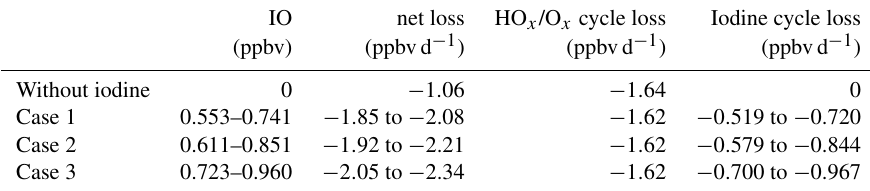
Table 4. Net and process-specific O 3 loss rates in three cases at an O 3 concentration of 10ppbv, as calculated using the box model.